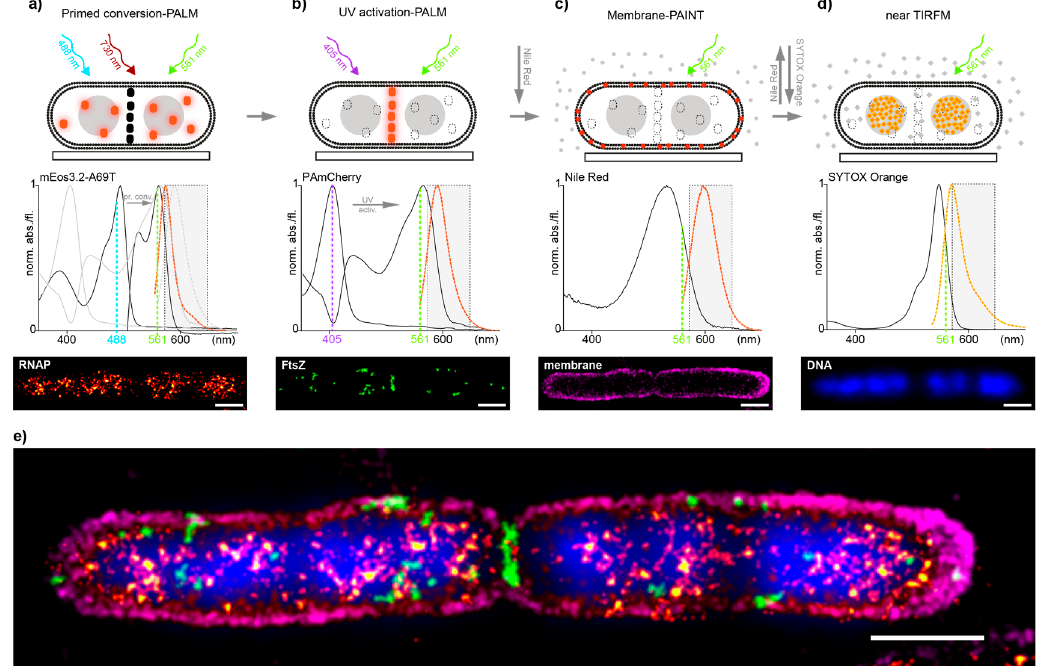
Figure 1. ( a – d ) Multi-color imaging workflow in E. coli cells. Top: scheme representing the acquisition sequence by first imaging RNAP-mEos3.2-A69T (orange dots) by primed conversion-PALM, not activated FtsZ-PAmCherry molecules are depicted as black dots ( a ); FtsZ-PAmCherry (orange dots) by UV activation-PALM, permanently bleached RNAP-mEos3.2-A69T are presented as dashed-lined white dots ( b ); The outer membrane by PAINT using NileRed- red dots depict fluorescent fraction of NileRed molecules in the membrane, whereas gray dots represent non-fluorescent NileRed in buffer/medium ( c ) and last the DNA stained by SYTOX Orange (orange diamonds) and read-out by near TIRF microscopy ( d ). Middle: Measured absorption and emission spectra of all four fluorophores used (Supplementary Material and Methods). Dashed line rectangle represents the optical bandpass-filter used to visualize the fluorescence channel of all four acquisitions. Bottom: SMLM image reconstructions ( a – c ) and nearTIRF-snapshot ( d ) recorded; ( e ) Overlay of all individual images to show the mutual organization of imaged compounds, aligned by fiducial markers (Supplementary Material and Methods). Localization precision of the channels after drift correction (whole ROI, NeNA values): mEos3.2-A69T (RNAP) 12.1 nm, PamCherry (FtsZ) 12.3 nm, NileRed (membrane) 11.8 nm, scale bars: 1 μ m.